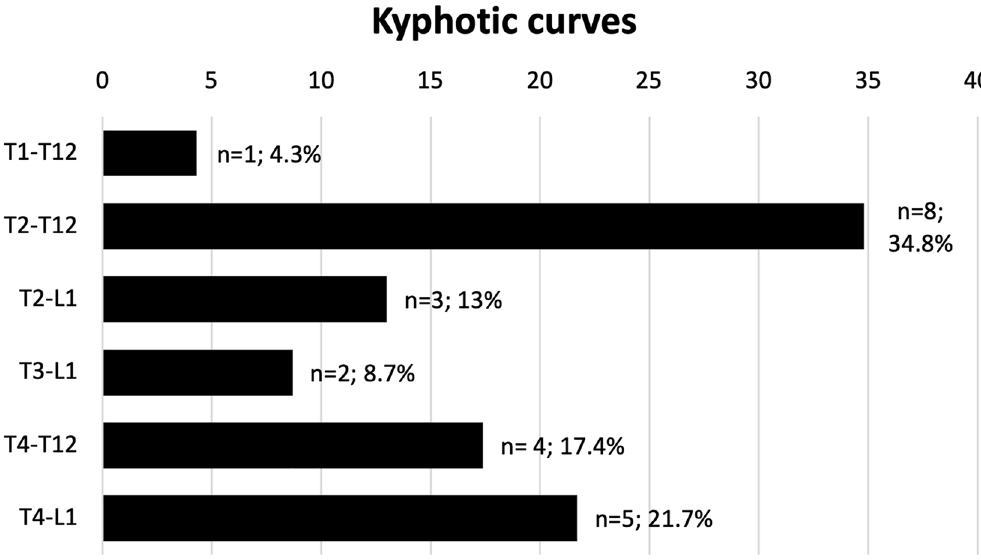
Figure 1. Frequency and involved levels of the kyphotic curves.